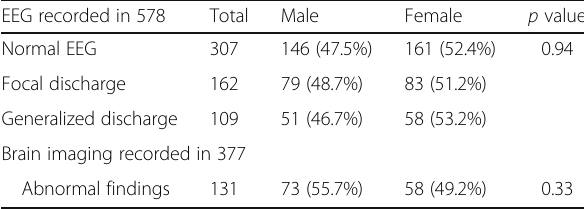
Table 5 Gender differences in diagnostic studies